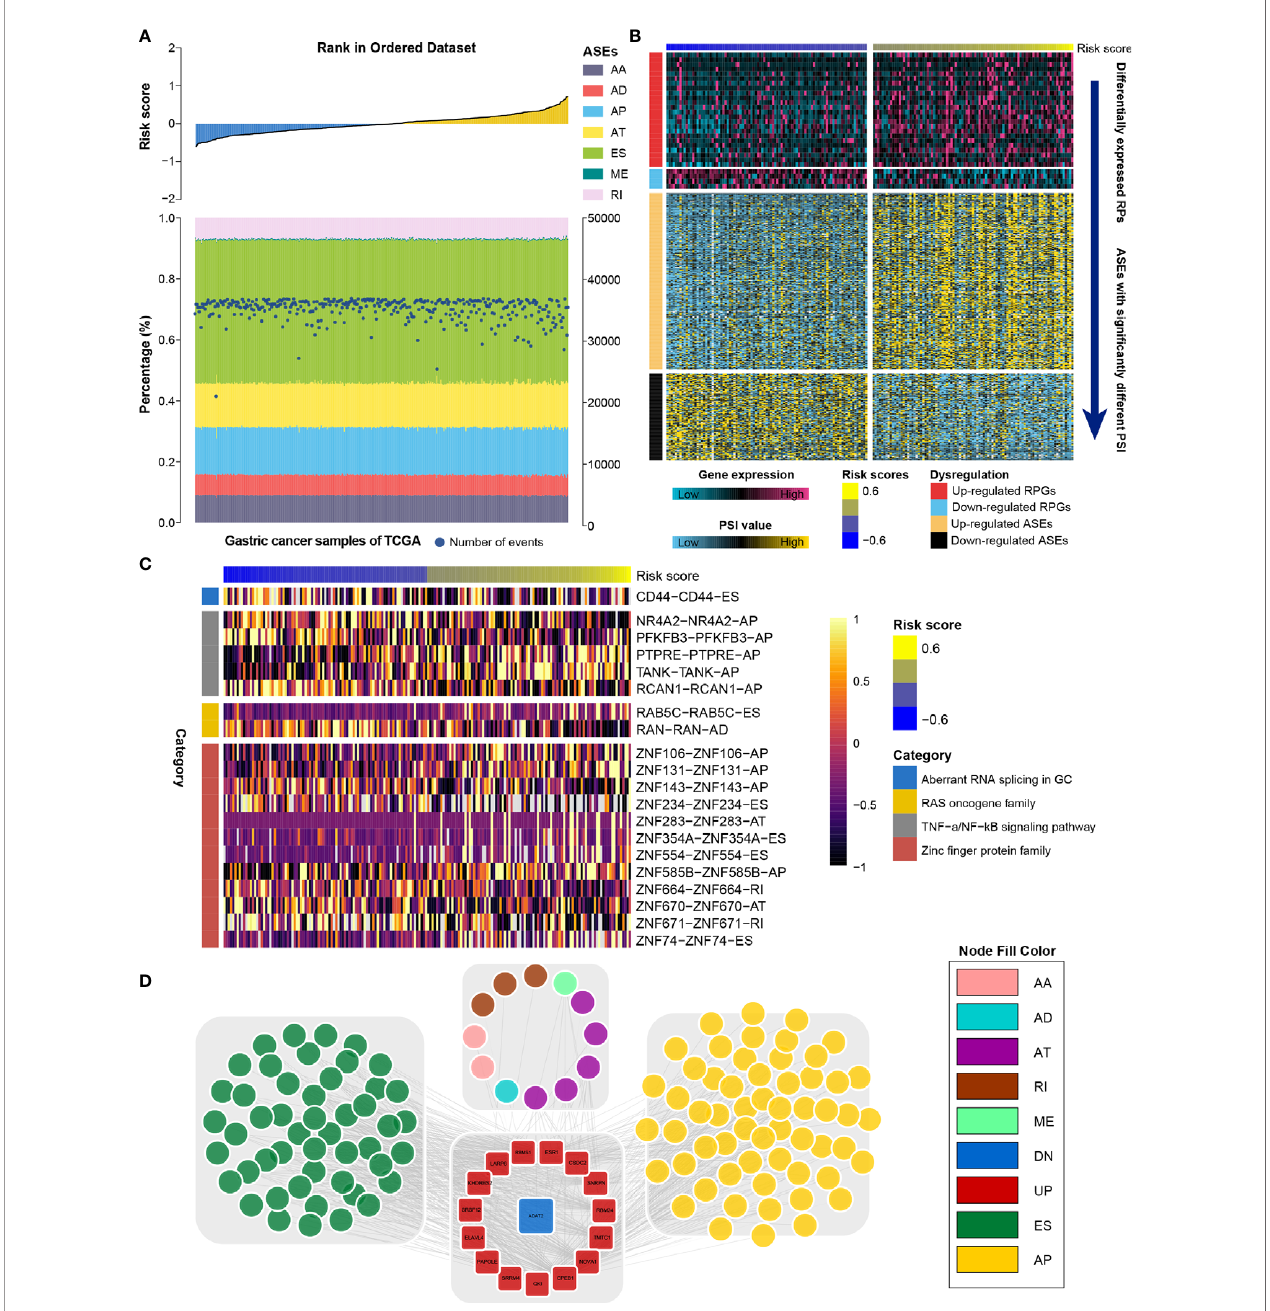
FIGURE 8 | Identi fi cation of the RNA splicing landscape underlying the RNA processing-related prognostic signature. (A) Proportions of ASEs in 375 TCGA samples sorted by increased risk score. Bars indicate the proportion of each ASE type. Dark blue dots indicate the number of ASEs in each sample. The risk scores in ascending order are shown in the top panel. (B) Heatmaps showing the expression levels of RNA processing factors (top panel) and PSI value of ASEs with signi fi cant differences between lower-risk and higher-risk groups (bottom panel). (C) Representative ASEs with differential PSI values between lower-risk and higher-risk groups. (D) Network plot showing the correlation between RNA processing factors and ASEs with signi fi cant differences between lower-risk and higher-risk